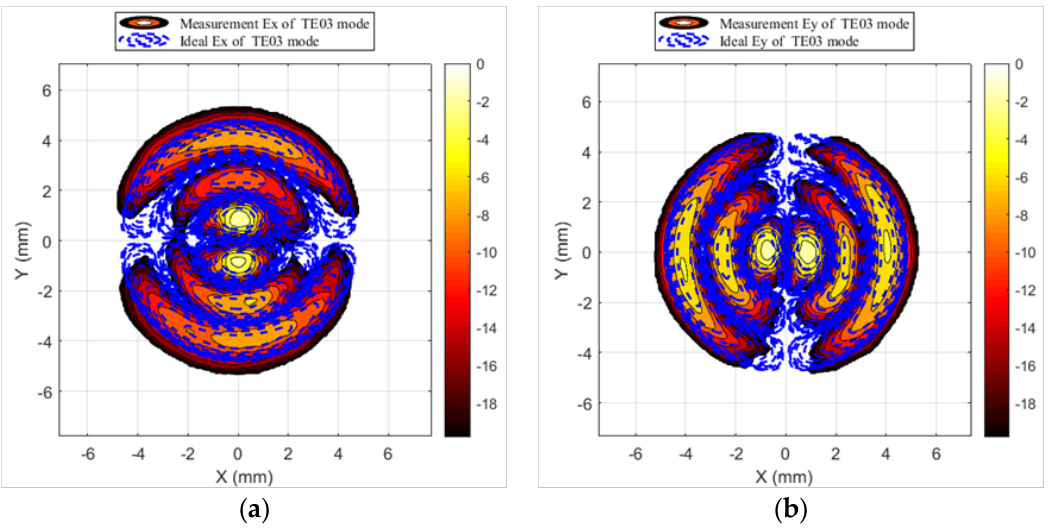
Figure 7. ( a ) The test results of E x of TE 03 mode; ( b ) the test results of E Y of TE 03 mode.